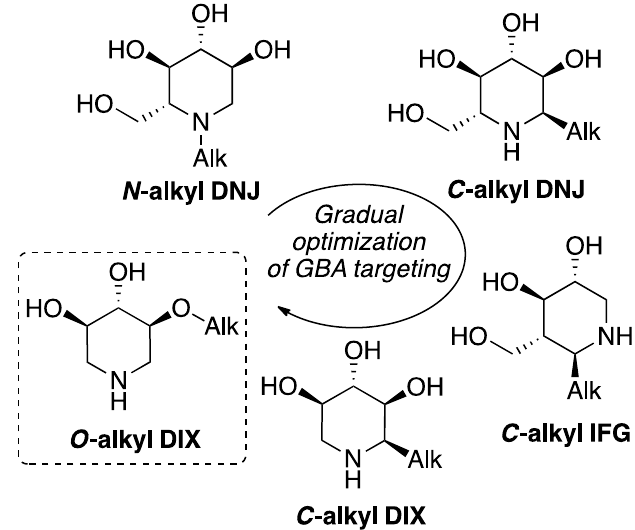
Figure 2. Structural evolution of GBA-targeting alkylated iminosugars.